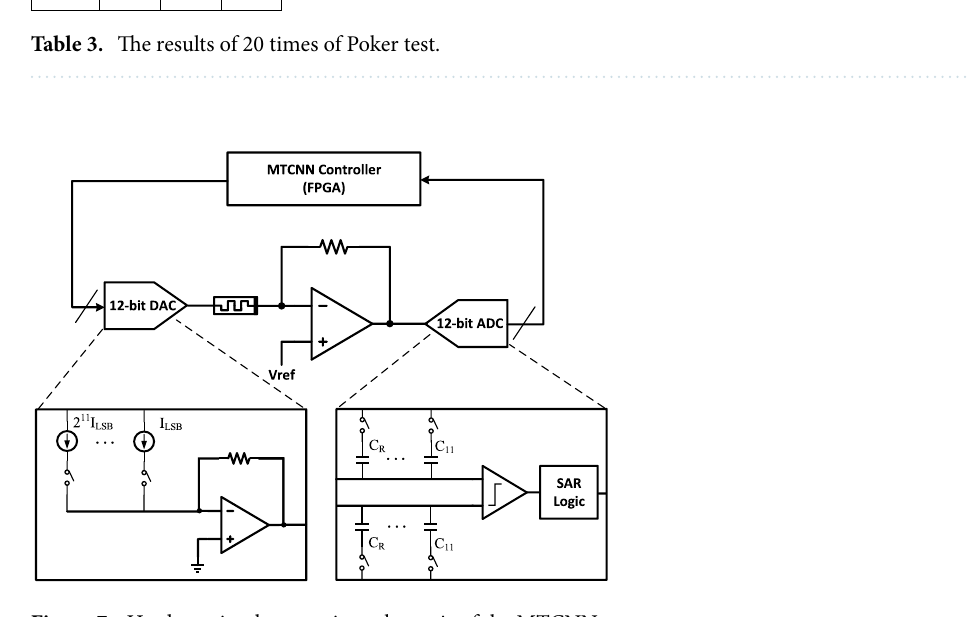
Figure 7. Hardware implementation schematic of the MTCNN